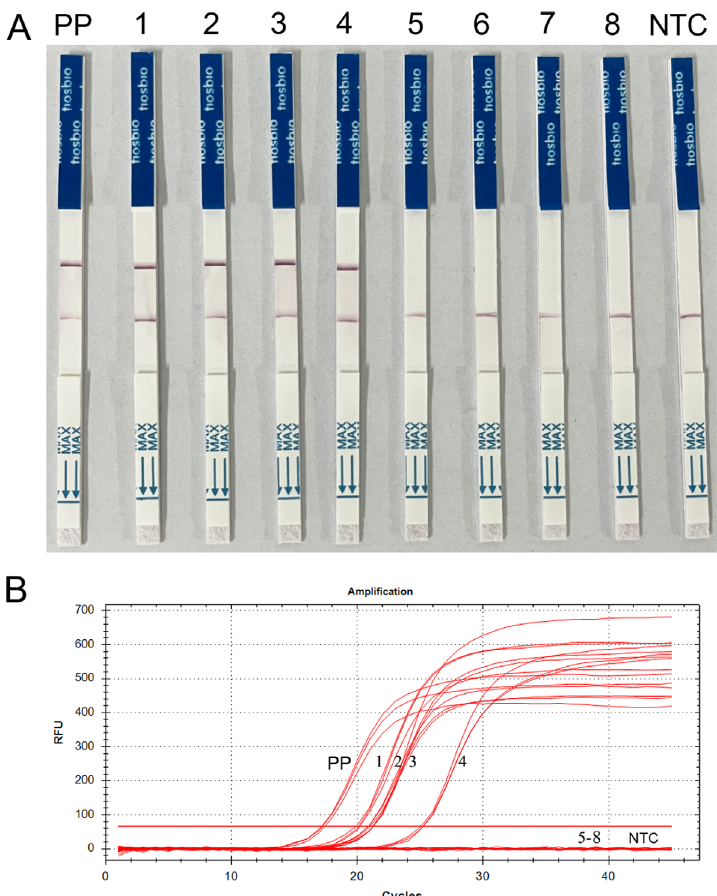
Figure 8. Toxoplasma gondii detected in the blood samples via RAA-Cas13a-LFD and qPCR. (A) Visual inspection of RAA-Cas13a-LFD; (B) Curves for qPCR. Strip and curves: 1 – 4: positive sample; 5 – 8: negative samples; PP: Positive plasmid of T. gondii ; NTC: negative control (ddH 2